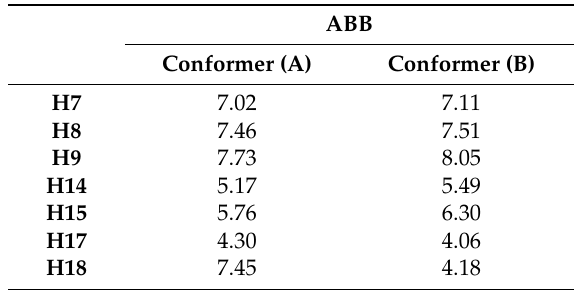
Table 2. The computed GIAO 1 H-NMR chemical shifts of conformers ( A ) and ( B ) for ABB , numbering as per Figure 2.